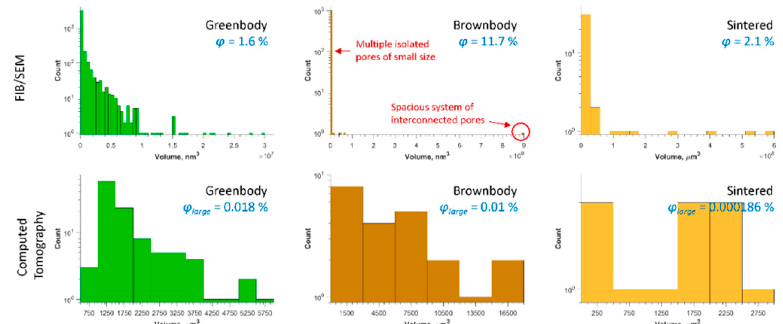
Figure 10. Volume distribution of single pores for FIB / SEM-based 3D images (top) and CT-based 3D images (bottom). The ϕ indicates the porosity of the samples, measured from FIB / SEM data. The ϕ large indicates the contribution of round pores to the volume of the samples, investigated with the CT method.